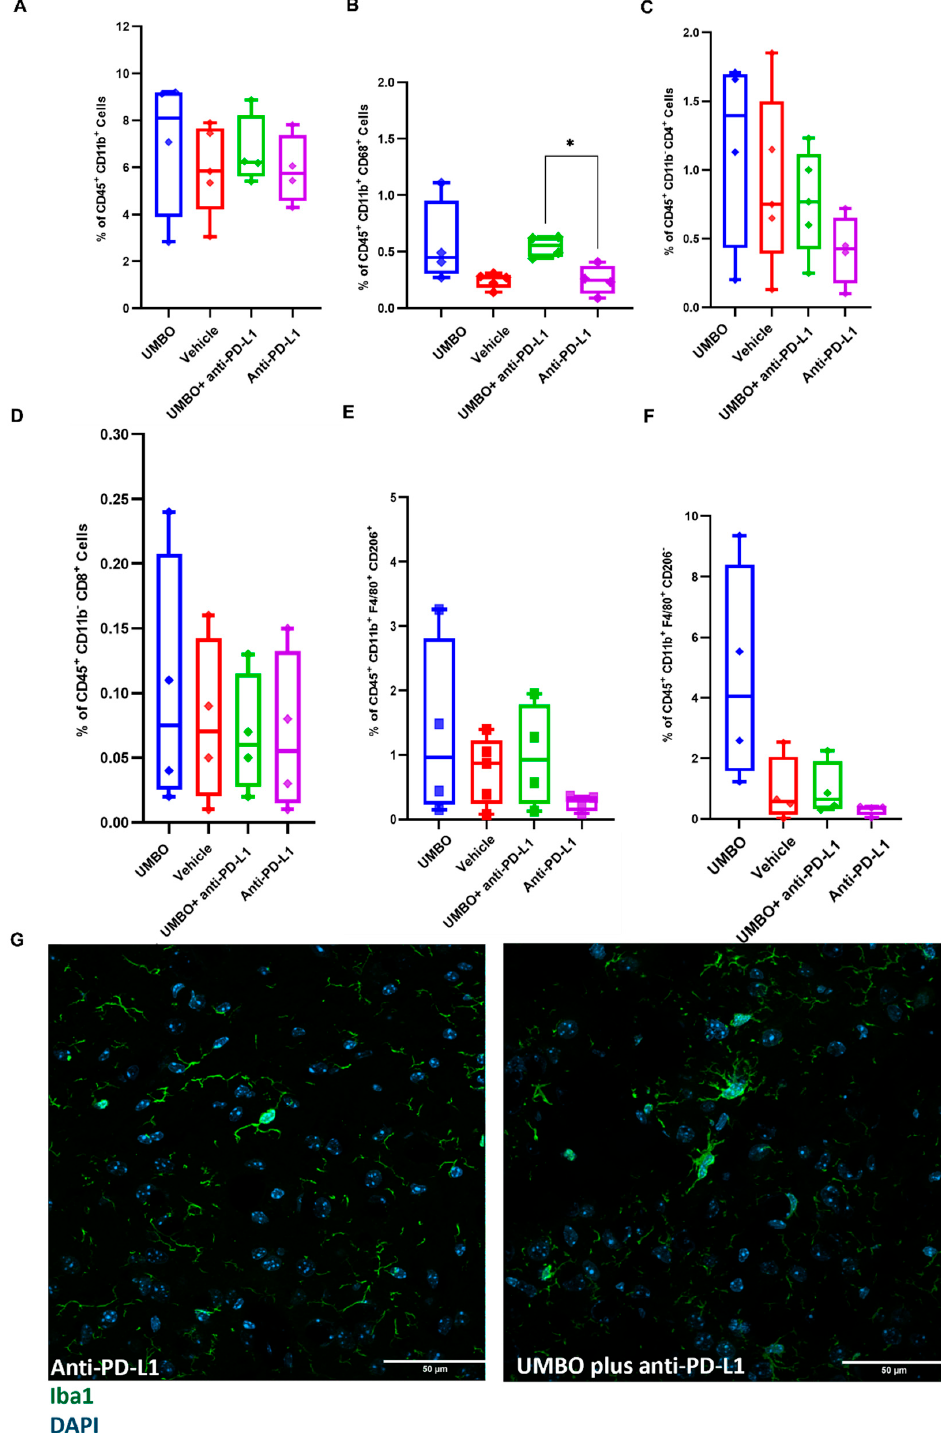
Figure 5. UMBO plus anti-PD-L1 activates microglia and modulates microglial phenotype. (Panel A ): Flow cytometry analysis of the percentage of total microglia in all different groups ( n = 4–5). (Panel B ): UMBO plus anti-PD-L1 significantly enhanced (* p < 0.05) the percentage of CD68 + cells than an-ti-PD-L1 alone. (Panel C , D ): UMBO plus anti-PD-L1 did not influence CD4 + and CD8 + T-lymphocytes percentages compared to other groups. (Panel E , F ): No significant difference in CD206 + and CD206 − macrophages in all groups. UMBO plus anti-PD-L1 did not modulate macrophages’ expression. (Panel G ): Green: Iba1 microglia/macrophages Blue: DAPI nuclear staining; microglia staining in anti-PD-L1 plus UMBO (right photos) treated group confirm a phenotype of activated